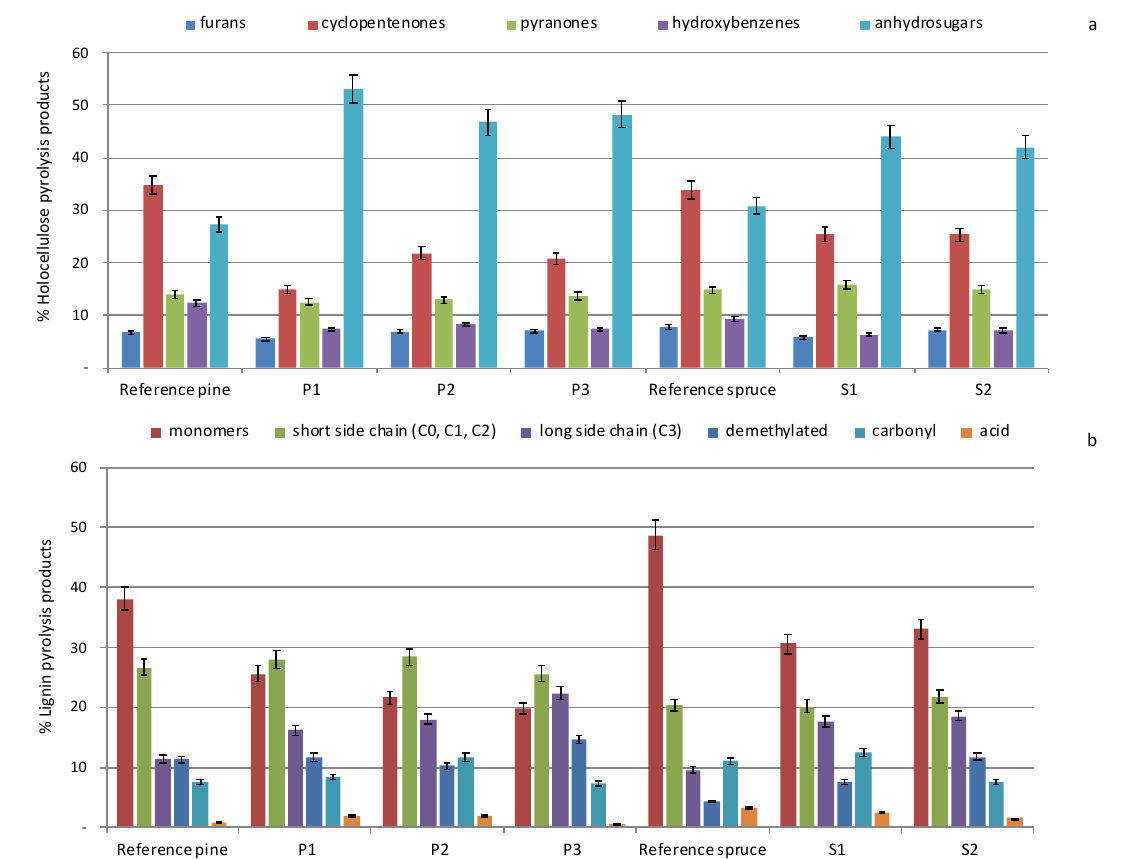
Figure 4. Distribution of ( a ) holocellulose and ( b ) lignin pyrolysis products from sound pine (Reference pine) and spruce (Reference spruce) wood samples, and archaeological pine (P1, P2 and P3) and spruce (S1 and S2) wood specimens. Relative abundances are expressed as percentages relative to total holocellulose ( a ) and total lignin fractions ( b ), respectively.